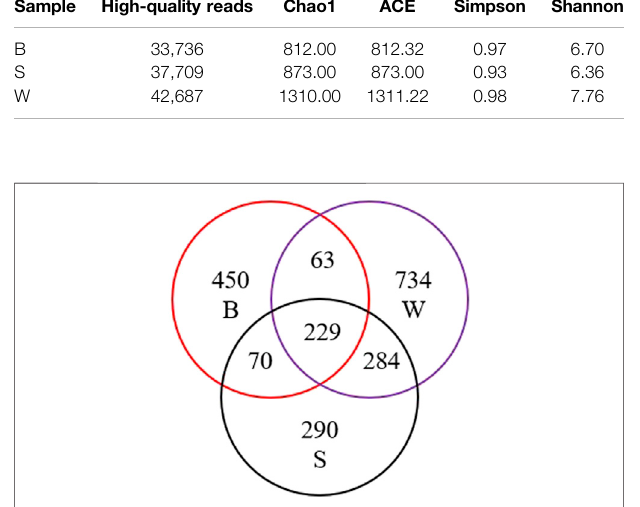
FIGURE 3 | Venn diagram of OTUs in B, S, and W samples.